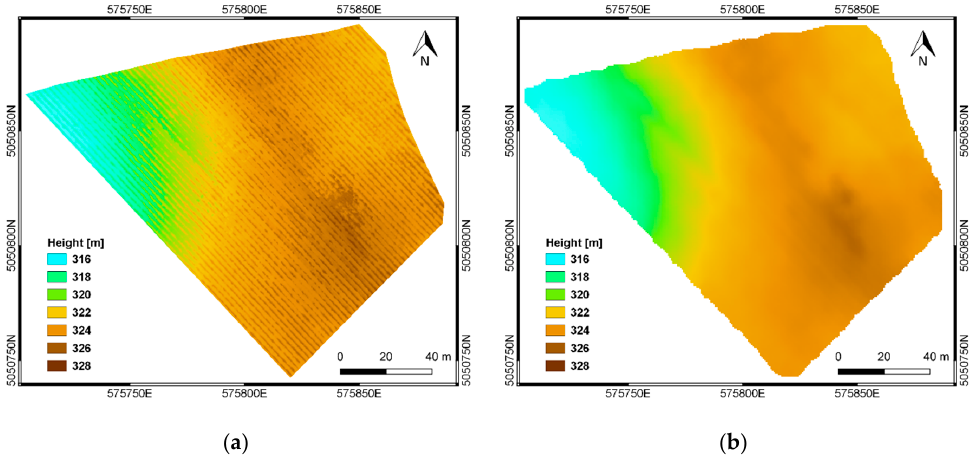
Figure 6. DSM ( a ) and DTM ( b ) produced through photogrammetric processing of multispectral (VIS-NIR) dataset.